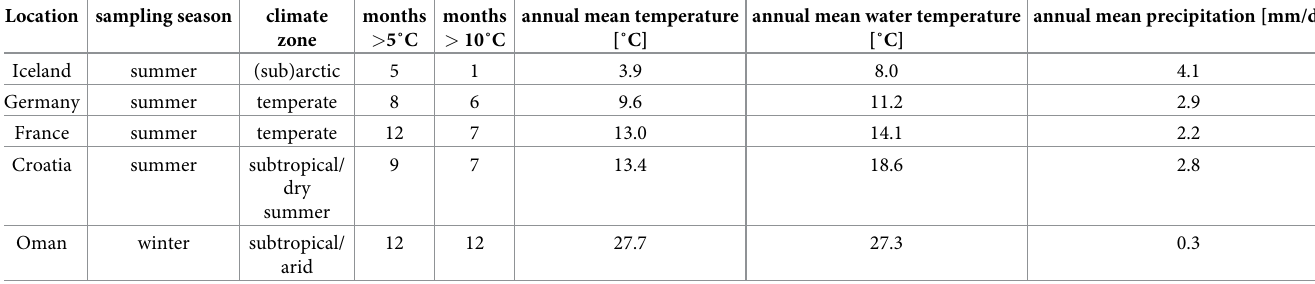
Table 1. Climatic characteristics of the sampled locations.